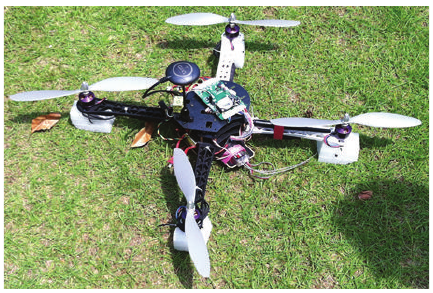
Figure 2: Quadrotor platform.